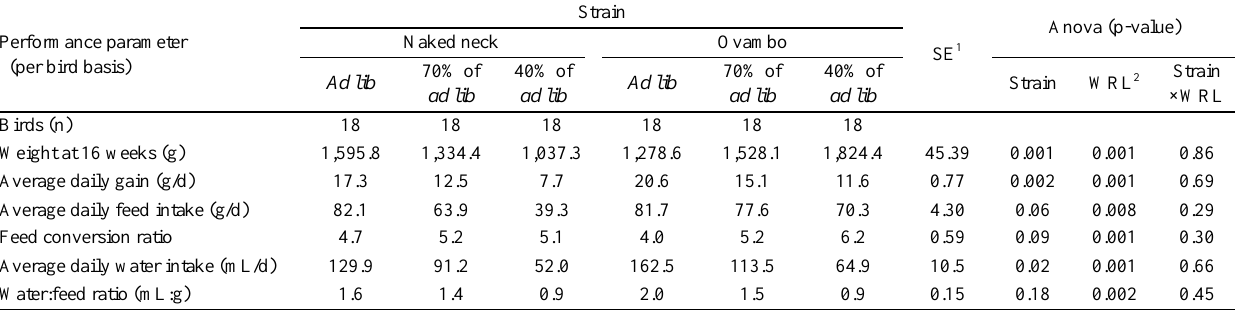
Table 3. Performance parameters of Naked Neck and Ovambo chickens raised with or without water restriction Performance